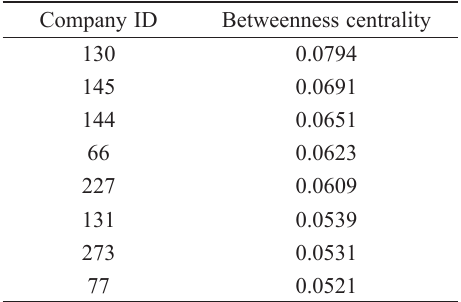
Table 4. The highest betweenness centrality scores of the general network Company ID